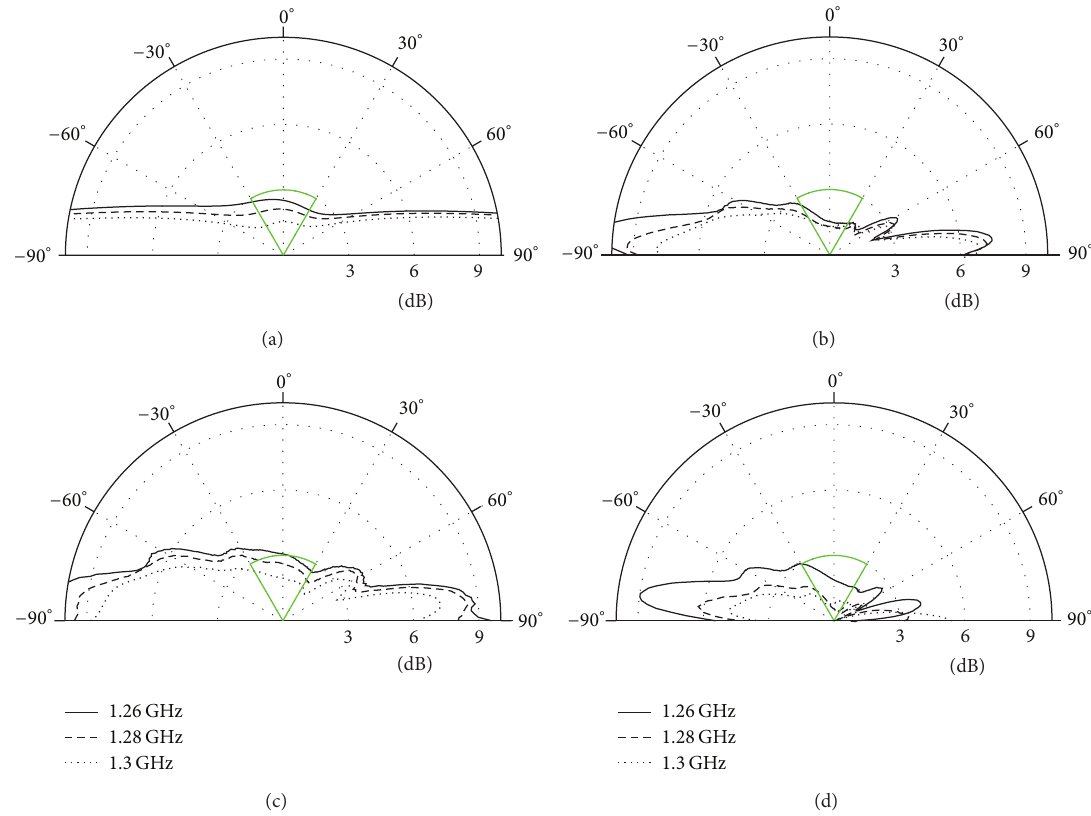
Figure 6: Simulated (a) and measured ((b), (c), and (d): prototype 1, prototype 2 before postoptimization, and prototype 2 after postoptimization, resp.) AR of the Galileo E6-band antenna, together with the 3 dB limit specified by the design requirements (green).